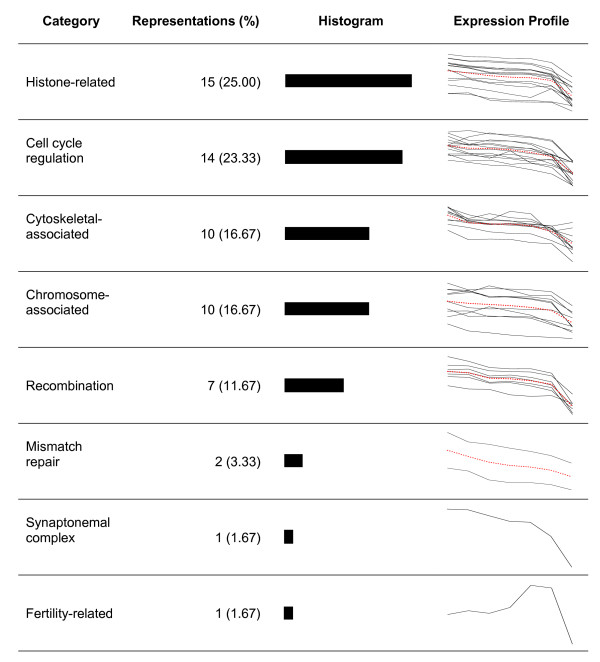
Functional classifications for the 60 meiosis and/or cell division transcripts identified from Table 1. These transcripts were classified into functional categories based on the annotation obtained. The histogram represents the absolute values for each category, while the expression profiles for each of the candidates within each of the categories has also been shown. The red dotted line in the expression profile graphs represents the overall trend line for that category.